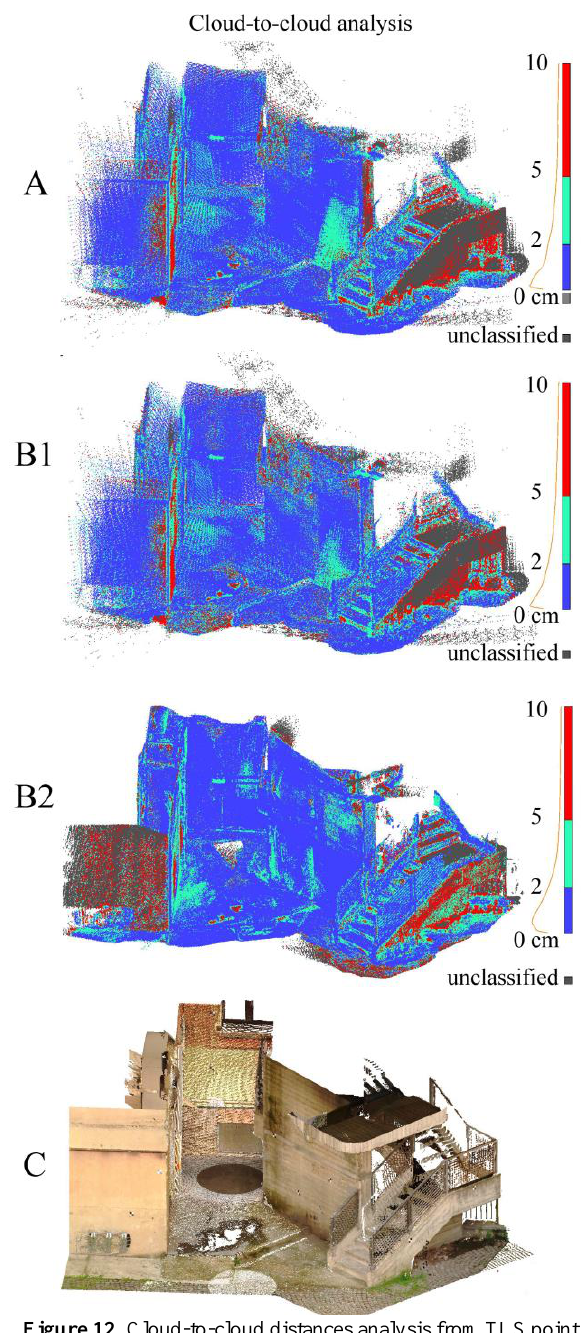
Figure 12 . Cloud-to-cloud distances analysis from TLS point cloud (C) of: (A) the lowest resolution iPad point cloud, (B1) raw higher resolution iPad point cloud, (B2) edited higher resolution iPad point cloud. In blue points within a distance range of 0-2 cm, in teal 2-5 cm, in red 5-10 cm, in grey gross